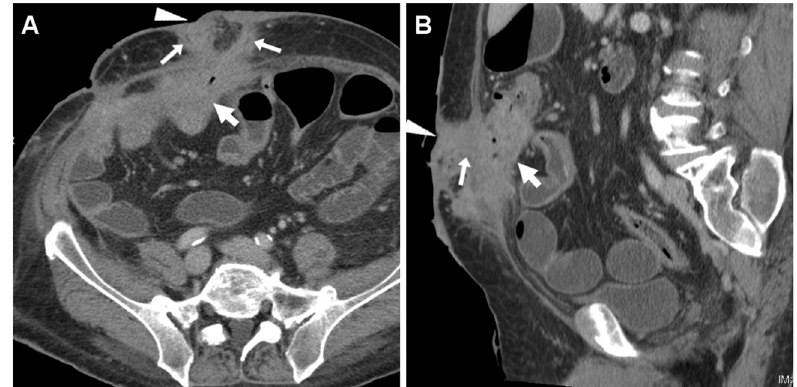
Fig. 12 Ileal adenocarcinoma fistulising to the skin in a 68-year-old man with long-standing CD, previous ileocecal resection, recent weight loss and two draining EFOs at the anterior abdominal wall. CT-enterography confirmed double ventral ECF (arrows) from a markedly thickened non- stratified ileal segment (thick arrows). Neoplastic infiltration of the